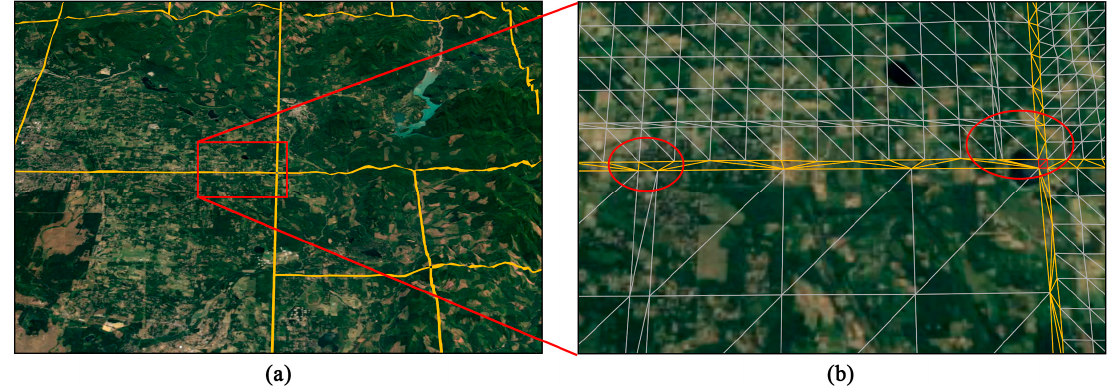
Figure 14. Effect of DSSs: ( a ) Part of the model that is seamlessly connected by DSSs and ( b ) Magnified view of the portion enclosed in the red rectangle in ( a ).